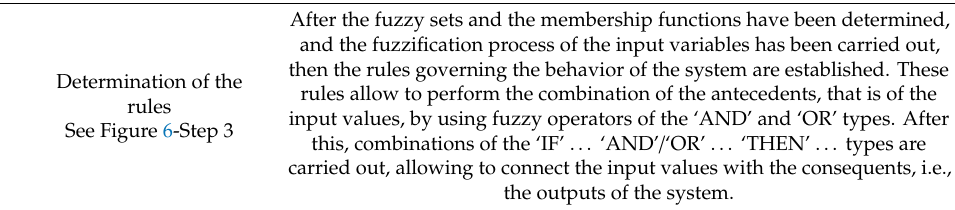
Figure 7. Technical Risk management panel.